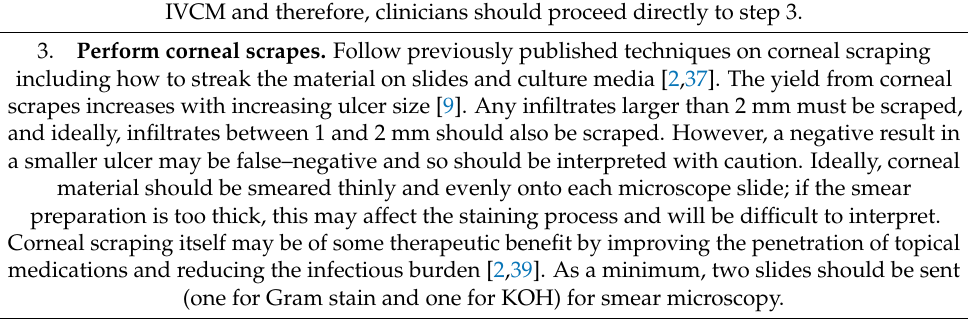
Table 4. Proposed diagnostic approach for clinicians working in low-resourced settings in tropical and sub-tropical latitudes where fungal keratitis is more